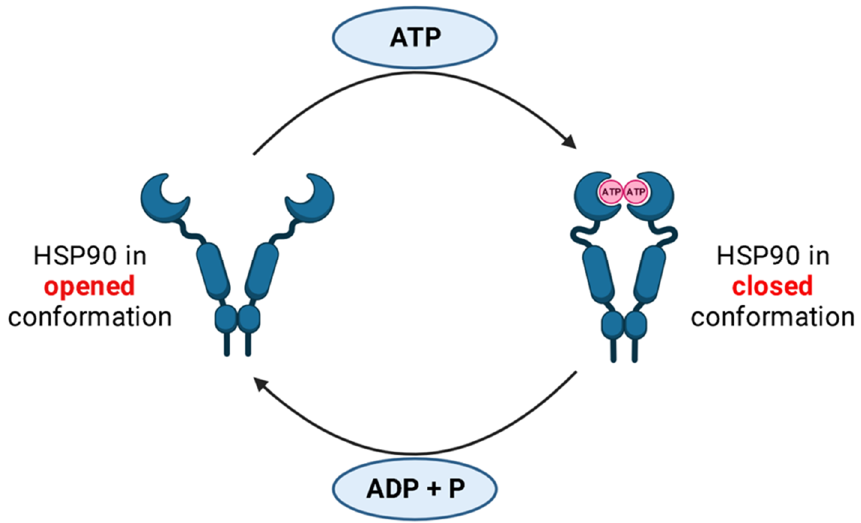
Figure 1. ATPase activity of HSP90 . The HSP90 ATPase cycle is shown schematically. HSP90 is shown in both its open and closed conformations. The three structural domains NTD, MD, and CTD constitute the monomers of the flexible homodimer HSP90. A series of conformational events are triggered when ATP binds to its binding cleft in HSP90’s NTD. The formation of a twisted and compressed dimer is caused by the translocation of a short N-domain fragment (ATP-lid) over the binding pocket and the subsequent attachment to the corresponding N-domain of the opposing homodimer. The N- and M-domains then shift closer to one another, completing the “split ATPase” site. Following ATP hydrolysis, the N-domains of the HSP90 homodimers split apart, releasing ADP and Pi while the HSP90 returns to its initial open conformation [29–31].